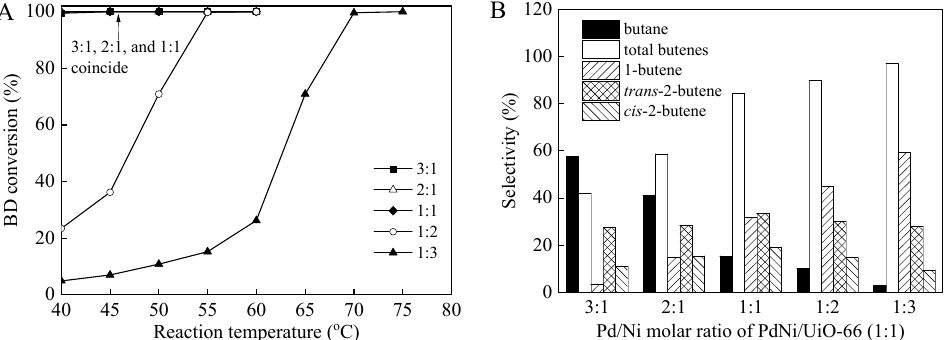
Figure 5. ( A ) BD conversions at different reaction temperature over PdNi/UiO-66 with diverse Pd/Ni molar ratios; ( B ) Product selectivities over PdNi/UiO-66 with diverse Pd/Ni molar ratios at nearly 100% BD conversion; (reaction conditions: 5 mg of catalyst, 6.5 mL/min of H 2 flow rate, 20 mL/min of 1.0 vol.%BD/N 2 flow rate. BD conversion and product selectivities given in ( A , B ) were stable data at reaction temperature).